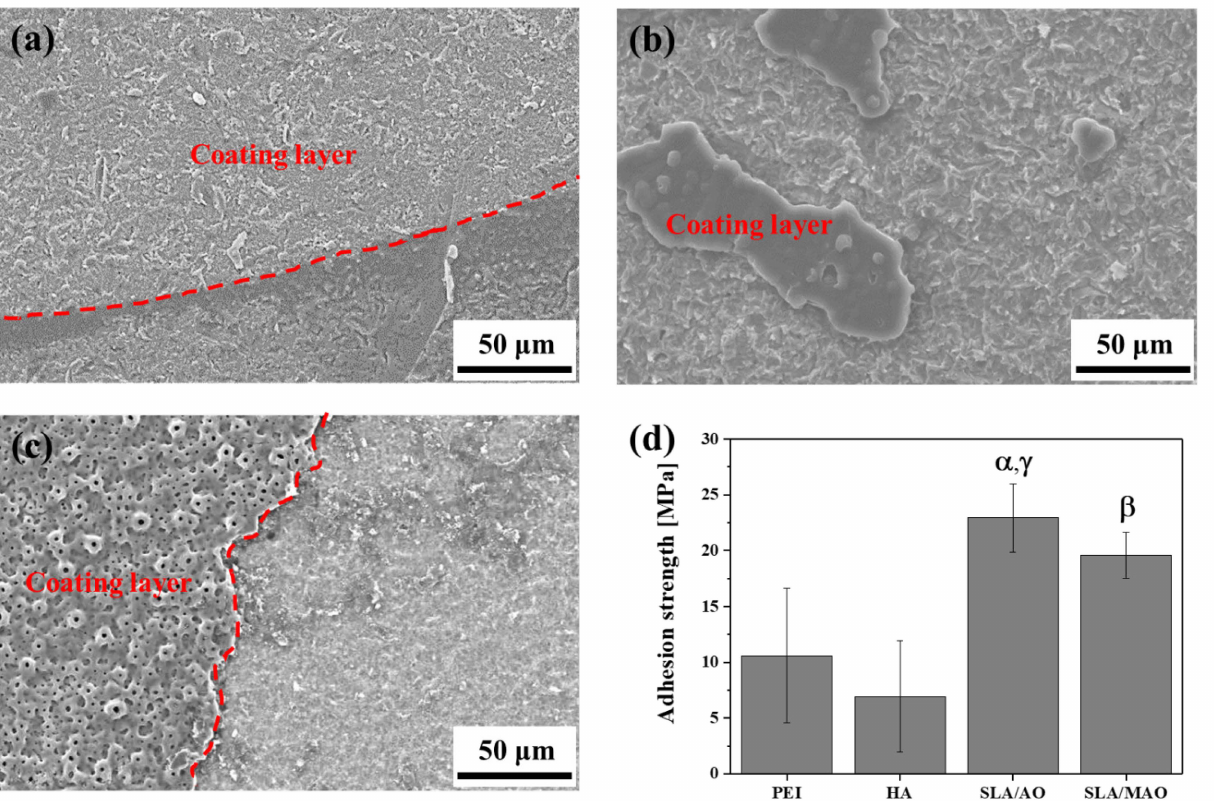
Figure 6. Surface morphology after detachment of coating layer of ( a ) HA, ( b ) SLA/AO, and ( c ) SLA/MAO. ( d ) quantita- tively measured adhesion strength ( α denotes p < 0.05 compared to PEI, β denotes p < 0.05 and γ denotes p < 0.01 compared to